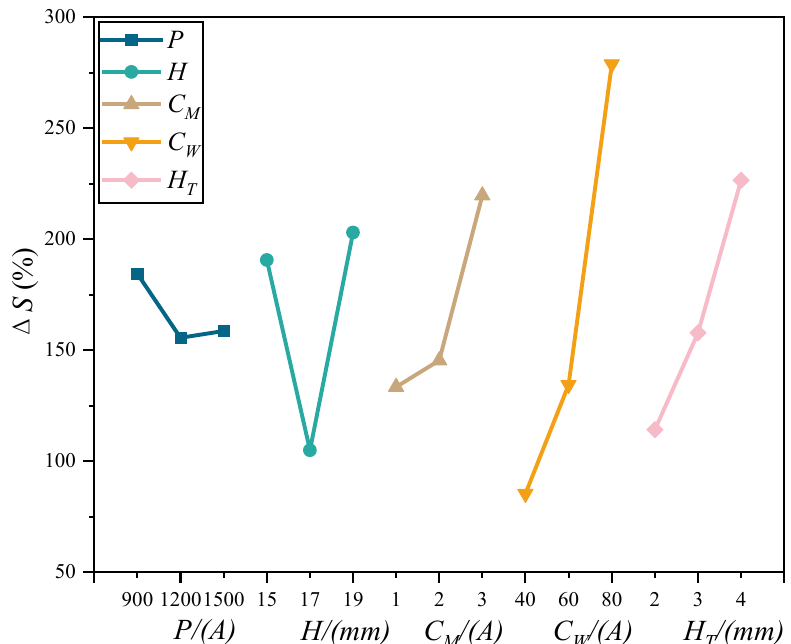
Figure 8. Trend diagram of Δ S with the variation of process parameters.